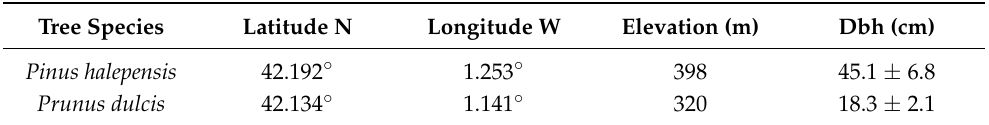
Table 1. Features of the two study sites. The values of the diameter at breast height (dbh) are means ± SD. Tree Species Latitude N Longitude W Elevation (m) Dbh (cm) Pinus halepensis 42.192 ◦ 1.253 ◦ 398 45.1 ± 6.8 Prunus dulcis 42.134 ◦ 1.141 ◦ 320 18.3 ±